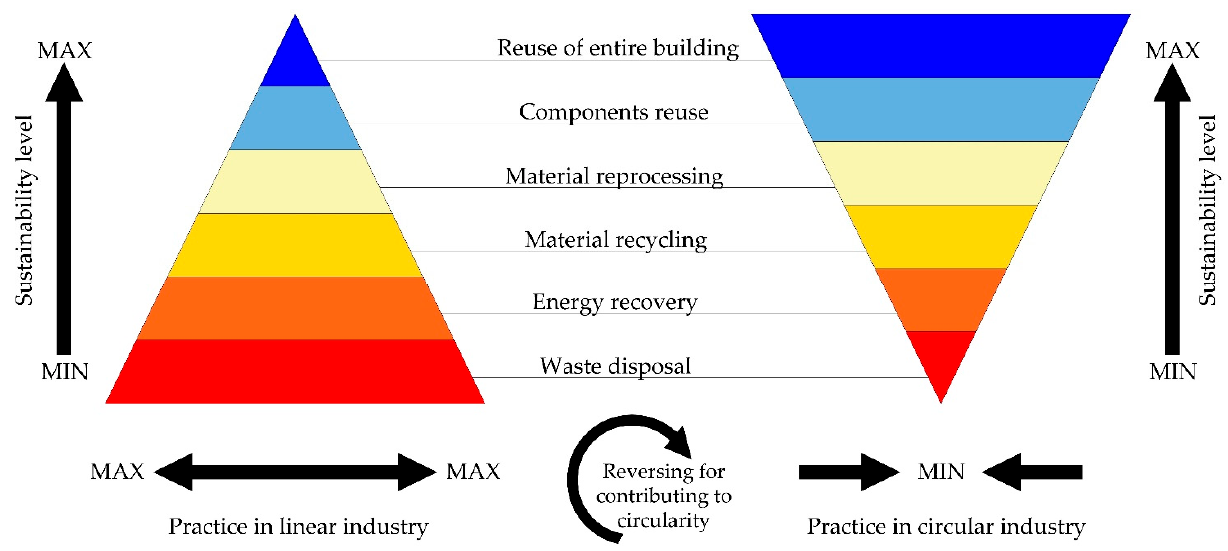
Figure 3. Sustainable hierarchy of end-of-life practices of a building (drawing by G.B.).